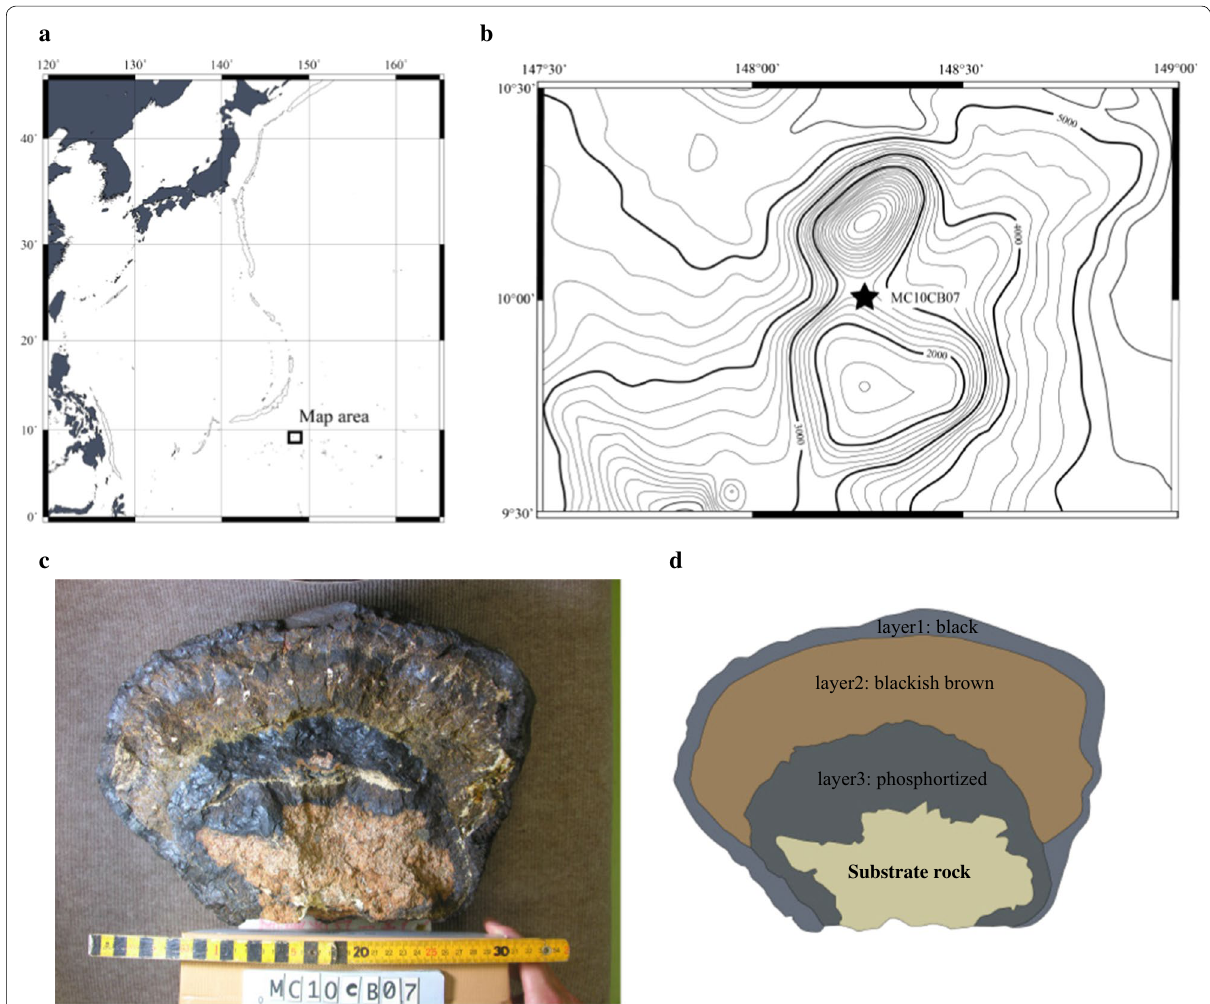
Fig. 1 Sampling sites, crust sample, and depth profiles used in chemical analysis. a Index map showing area of study around Micronesia in the northwestern Pacific. b Local map showing sampling site and bathymetry of area. c Photograph of crust sample MC10CB07 and d layers identified using naked eye observation that was primarily based on